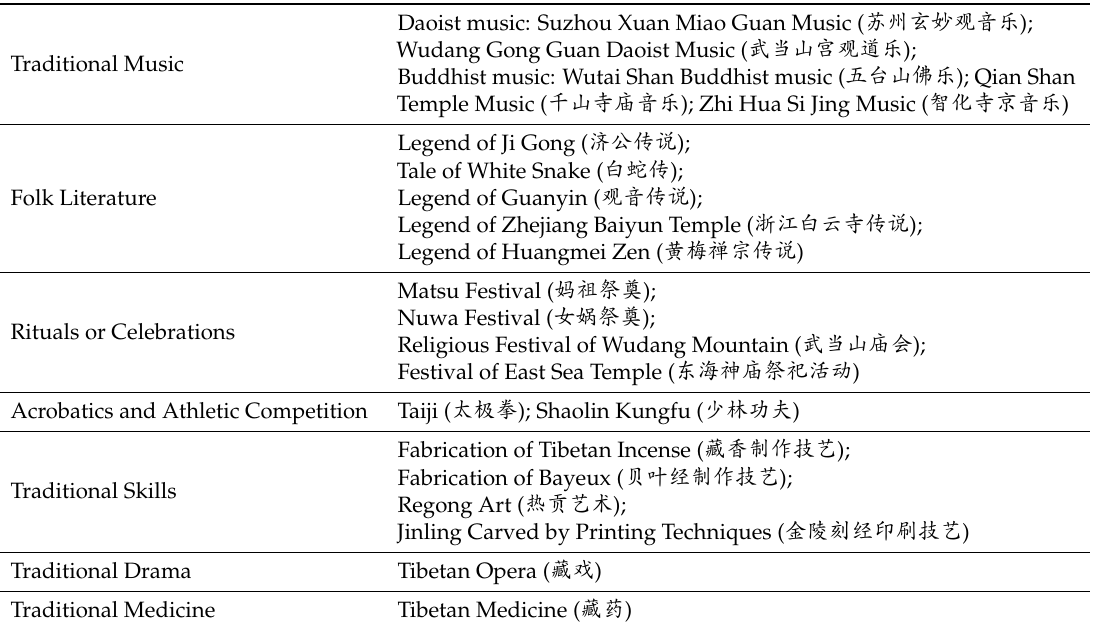
Table 2. Religious items included in the Catalogue of the Representative Items of Intangible Cultural Heritage at China’s National Level